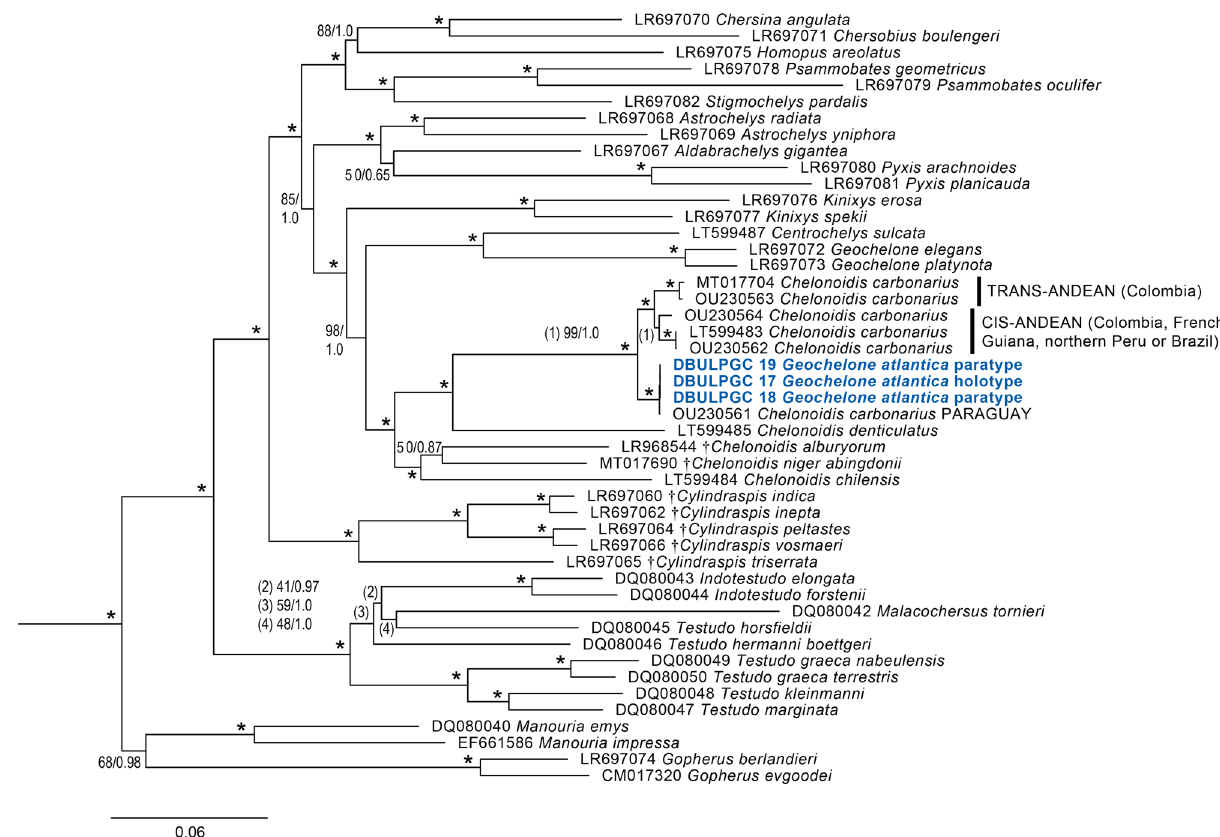
Figure 3. Maximum Likelihood tree for near-complete mitochondrial genomes (15,532 bp) of all species groups and genera of extant tortoises (Testudinidae), some recently extinct taxa and the type material of Geochelone atlantica López-Jurado, Mateo and García-Márquez, 1998 (blue). Numbers at nodes are thorough bootstrap values and posterior probabilities from a Bayesian 50% majority rule consensus tree. Asterisks denote maximum support under both approaches. Codes preceding scientific names are ENA/GenBank accession numbers or, for the type material, sample IDs. ENA accession numbers for the type material of Geochelone atlantica are OU230558-OU230560. Dagger symbols indicate extinct taxa. Outgroups ( Chrysemys picta , GenBank accession number AF069423; Mauremys reevesii , FJ469674) removed for clarity. Most sequences correspond to a previously published dataset 14–16 to which four new sequences for Chelonoidis carbonarius (OU230561- OU230564) and a new GenBank sequence for Gopherus evgoodei (CM017320) were